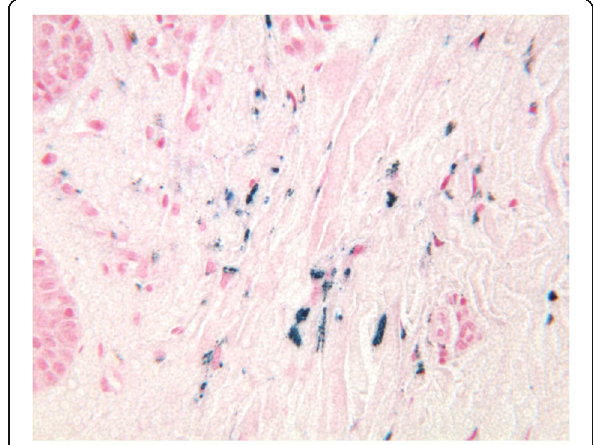
Fig. 3 The lamina propria of the oral mucosa contained blue-staining spherical particles that included iron (Perl ’ s stain, ×40)